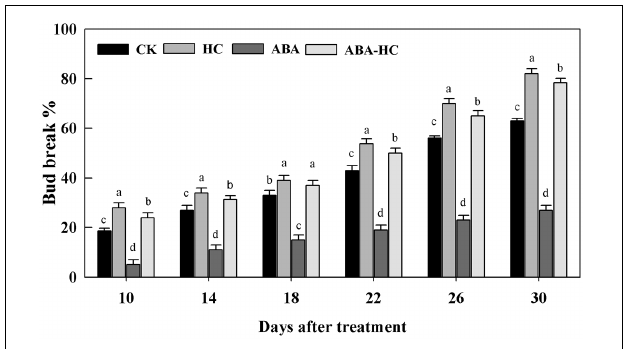
FIGURE 1 | Effect of HC, ABA, and ABA-HC application on bud break of single node cutting of cv. ‘Shine Muscat’ grape forced for 30 days under 25 ± 1 ◦ C 14/10 h dark/light conditions. Control buds were treated with water. Verticle lines above the means bars indicate standard error ( n = 3; p = 0.05) using Tukey’s HSD post hoc test. a–d represents significant difference between treatments.